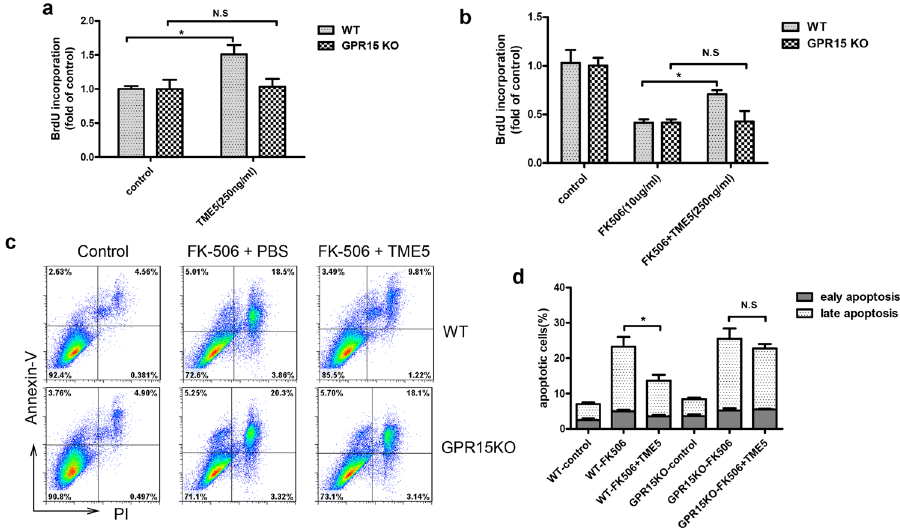
Figure 2. TME5 hampers growth inhibition and apoptosis caused by FK506 in murine vascular ECs in a GPR15 dependent manner. Vascular ECs isolated from wild type (WT) (n = 3) and GPR15 KO (n = 3) mice were cultured with TME5 (250 ng/ml) ( a ) or FK506 (10 μ g/ml) or combination of both ( b ) for 24 hrs. Proliferation was measured by bromodeoxyuridine (BrdU) incorporation assays. ( c ) ECs isolated from WT (n = 3) and GPR15 KO (n = 3) mice were exposed to TME5 and/or FK506 (10 μ g/ml). After 36 hrs, cells were stained with propidium iodide (PI) and PE-Cy5 anti-annexin V, followed by flow cytometric analysis. Early and late apoptotic cells are indicated by Annexin V + PI − and Annexin V + PI + cell populations, respectively. Figure represents one from three independent experiments. ( d ) Percentages of apoptotic cells in each group were shown (n = 3). Data are presented as mean ± SD, and compared using one-way ANOVA test. * p < 0.05; N.S., no